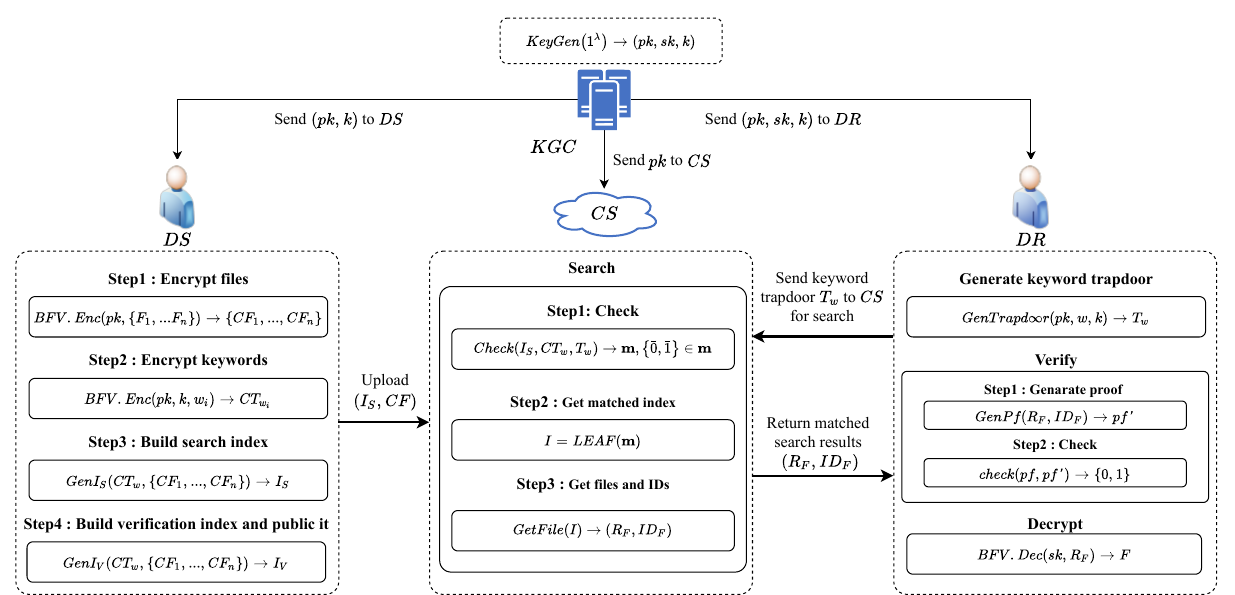
Figure 2. Algorithm flow chart of the proposed VR-PEKS scheme. The VR-PEKS algorithm is as